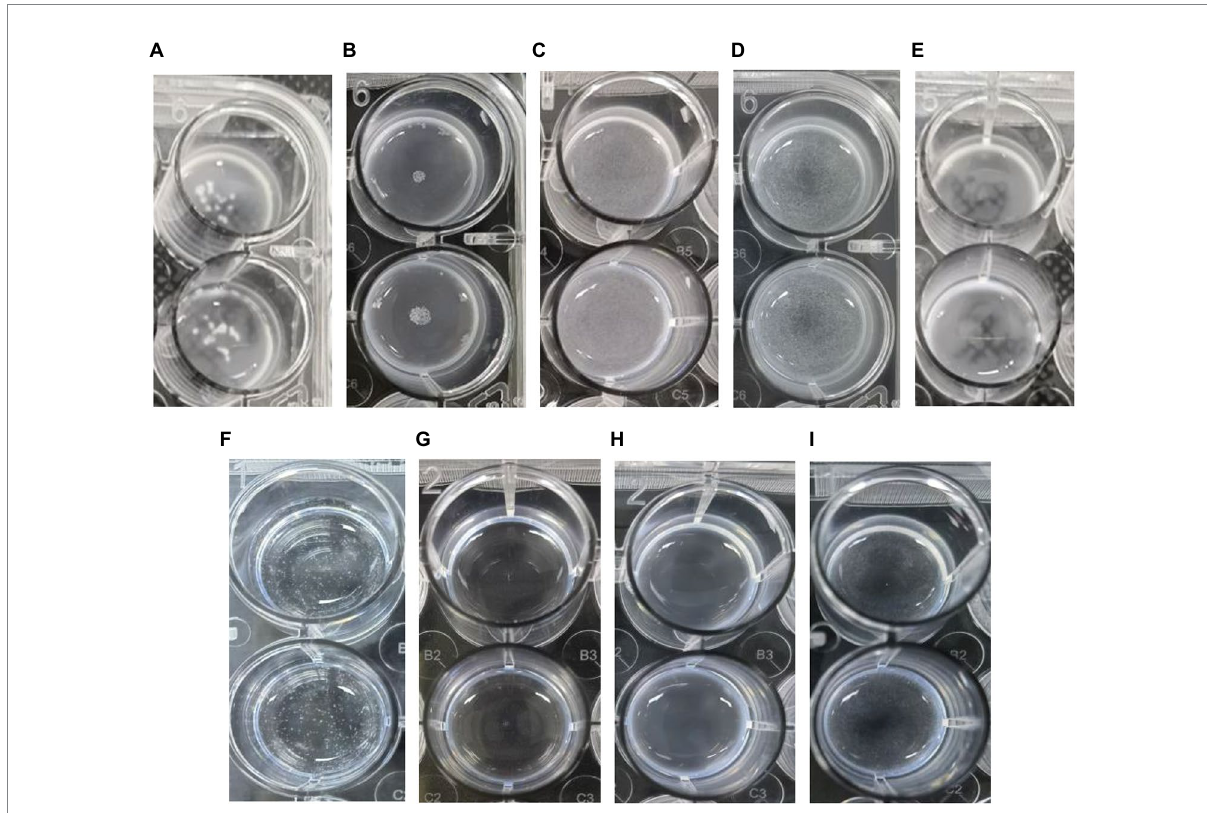
FIGURE 2 Coaggregation of L. plantarum VHProbi® V38 with four pathogenic bacteria. (A) L. plantarum VHProbi® V38 + S. mutans ; (B) L. plantarum VHProbi® V38 + A. actinomycetemcomitans ; (C) L. plantarum VHProbi® V38 + P. gingivalis ; (D) L. plantarum VHProbi® V38 + F. nucleatum ; (E) L. plantarum VHProbi® V38 control; (F) S. mutans control; (G) A. actinomycetemcomitans control; (H) P. gingivalis control; (I) F. nucleatum